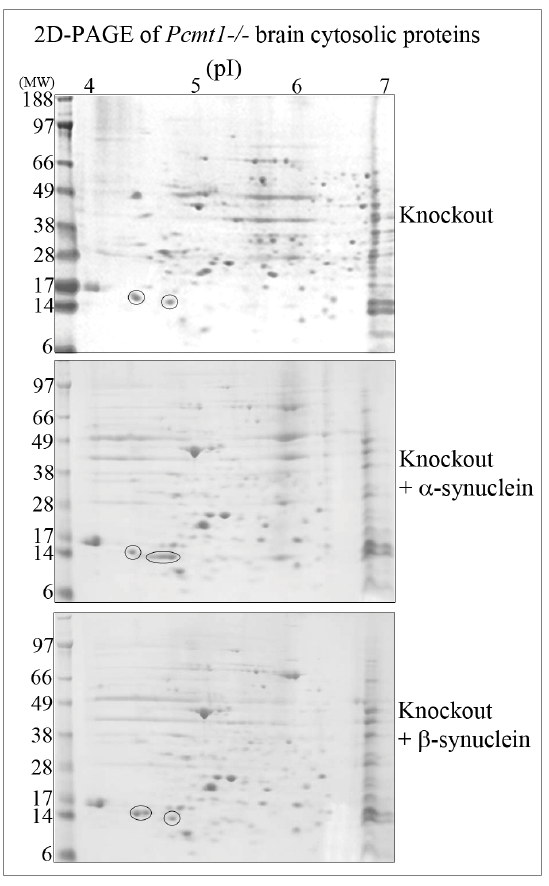
Figure 3. 2D-PAGE of Pcmt1 2 / 2 mice brain cytosolic proteins. Pcmt1 2 / 2 brain cytosolic proteins were resolved by 2D-PAGE and proteins stained with colloidal Coomassie blue (upper panel). Pcmt1 2 / 2 brain cytosolic proteins co-incubated with 5 m g of a -synuclein (middle panel) or 5 m g of b -synuclein (lower panel) prior to co- migrational 2D-PAGE. Protein spots identified as a -synuclein (right spot, ringed) and b -synuclein (left spot, ringed) were increased in their protein staining intensity with co-migrational analyses.